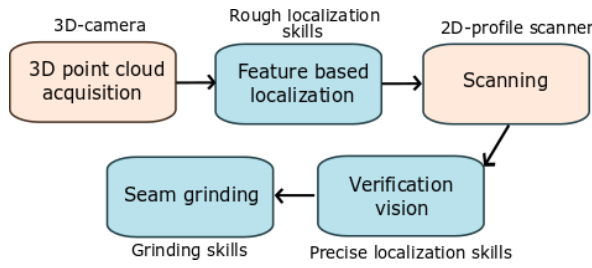
Figure 6: Skills in “grinding with localization” – task